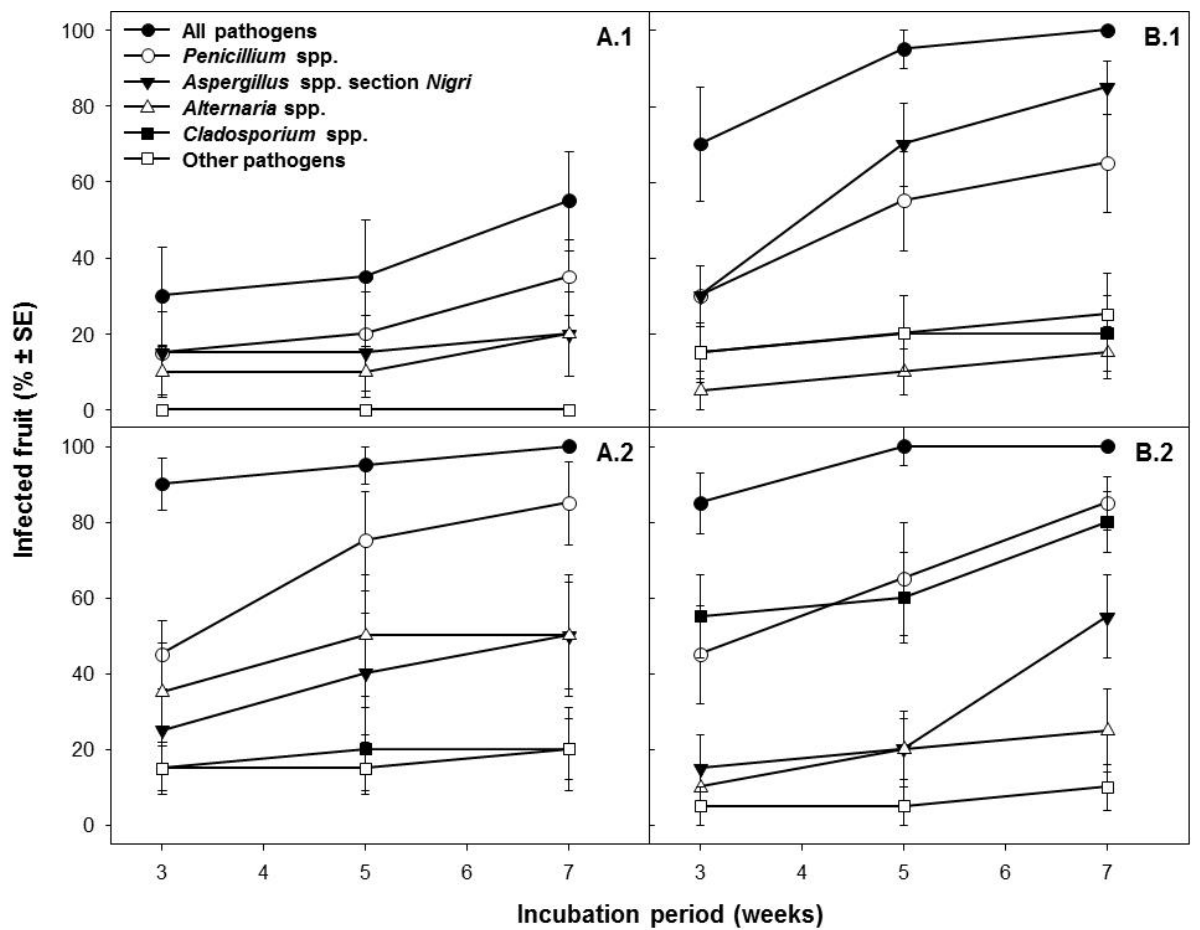
Figure 1. Incidence of postharvest fungal diseases from latent (A) and wound (B) infections on ‘Boufeggous’ dates from Elx (Spain), from two consecutive seasons, 2006 (1) and 2007 (2). Dates were surface-disinfected (A) or artificially wounded (B) and incubated at 20ºC in humid chambers for 7